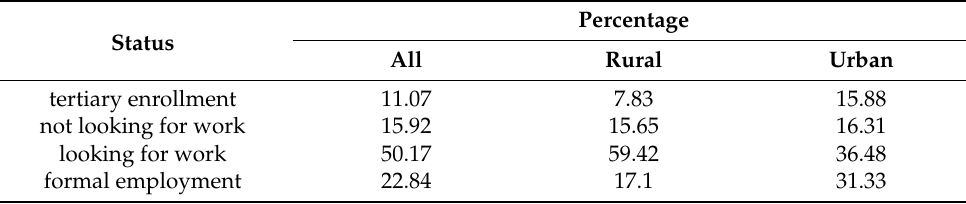
Table 5. Educational and labor market status of youth out of secondary